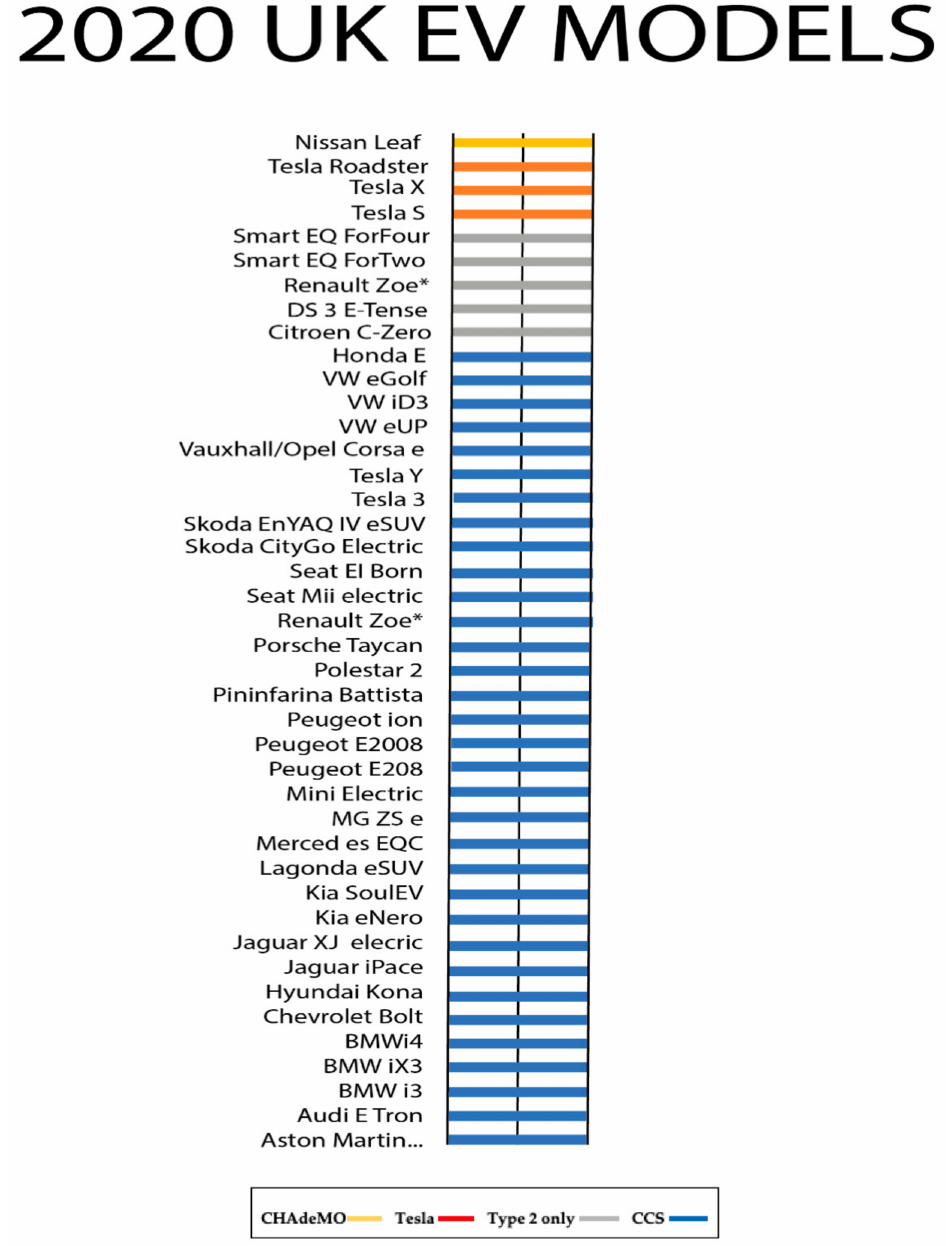
Figure 11. Charger connector types on UK EVs (sourced from each manufacturer—November